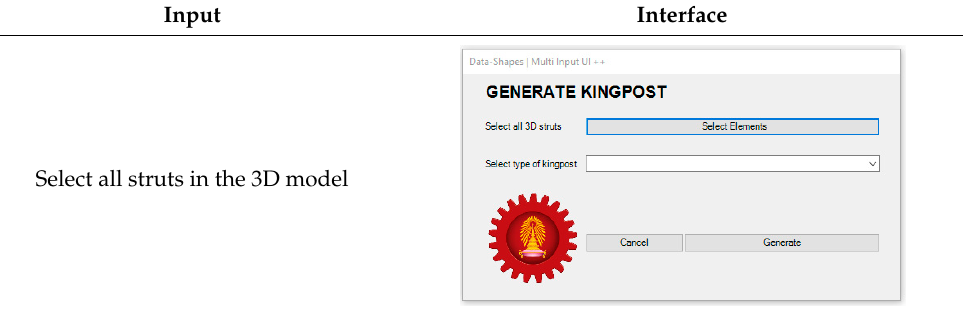
Table 6. The input and interface of the structural kingpost generation.